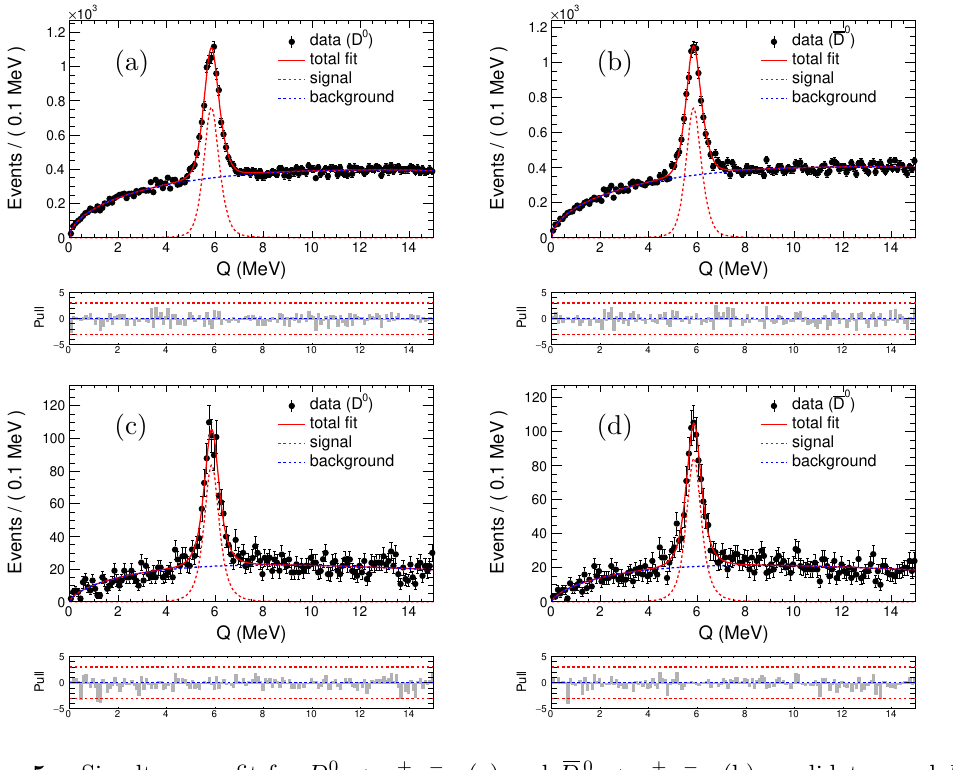
Figure 5 . Simultaneous fit for D 0 → π + π − η (a) and D 0 → π + π − η (b) candidates; and D 0 → K + K − η (c) and D 0 → K + K − η (d)